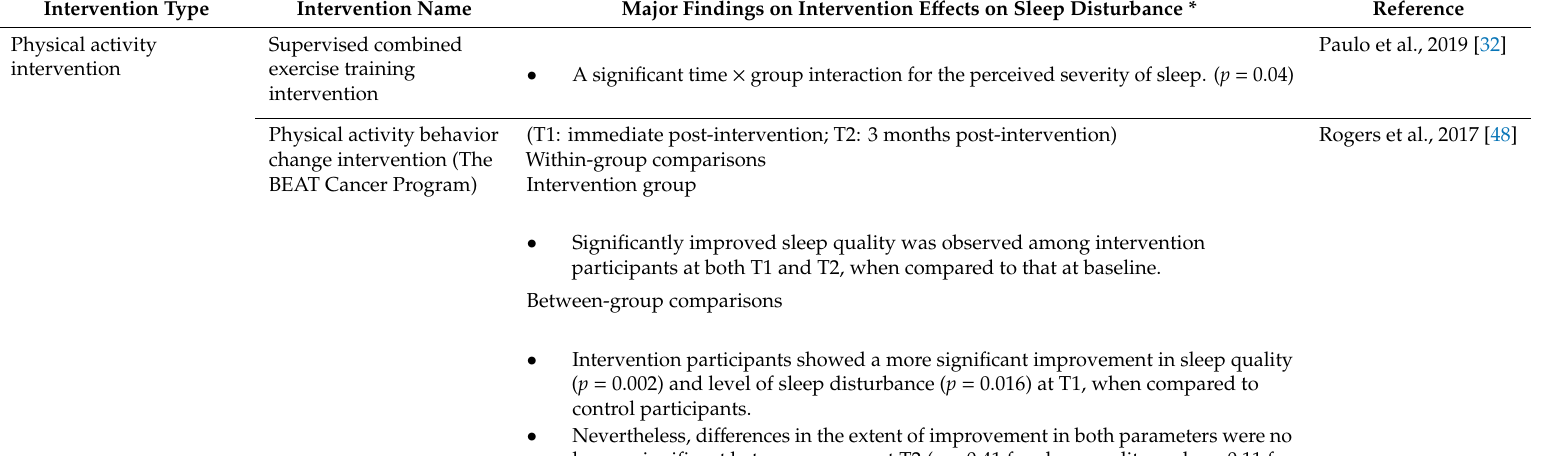
Table 7. A summary of the e ff ects of reported interventions on endocrine therapy-induced sleep